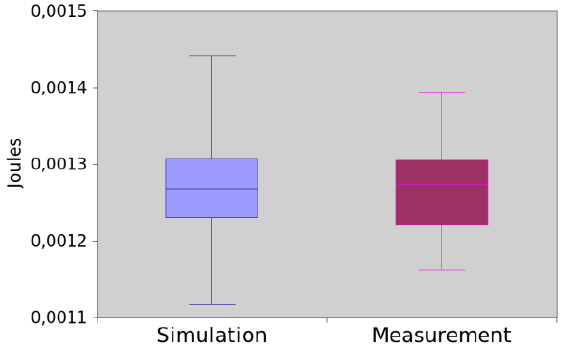
Figure 14. Power consumption of App2